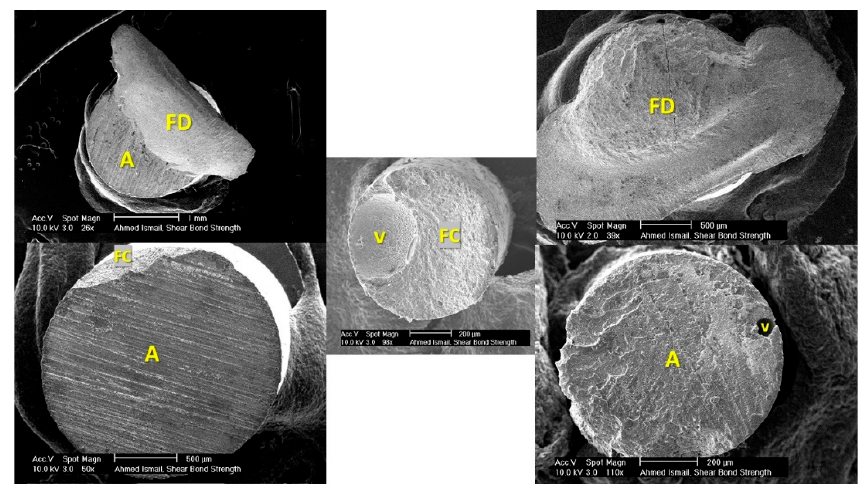
Figure 6. SEM images showing different failure modes in the corresponding composite; A = adhesive; V = void; FD = fractured dentin; FC = fractured composite.